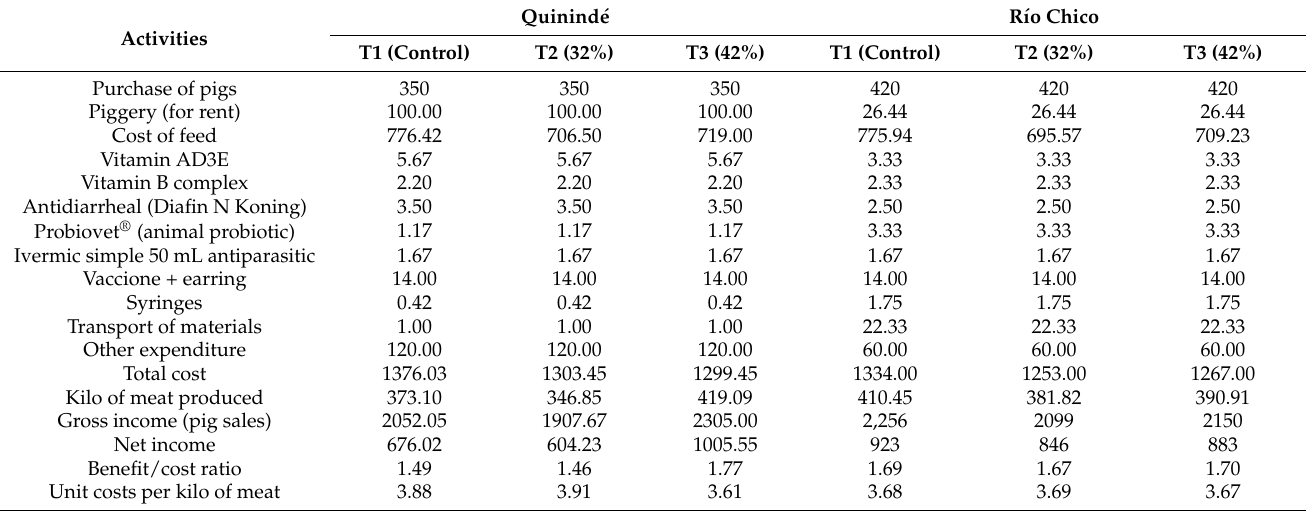
Table 8. Cost and benefit/cost (USD) of each pig group fed with alternative feeding based on cooked cassava and